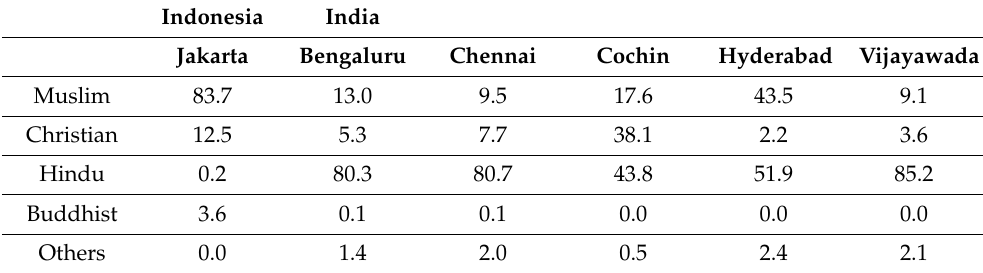
Table 1. The religious ratios in the study sites (unit: %).